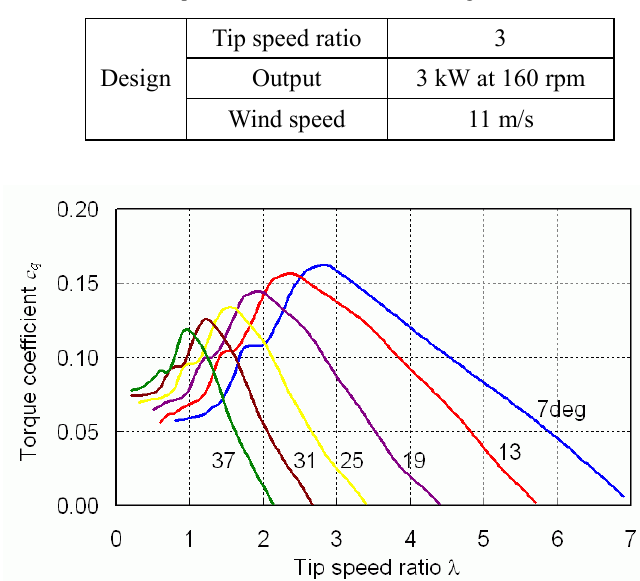
Table 1 Specifications of the wind turbine generator